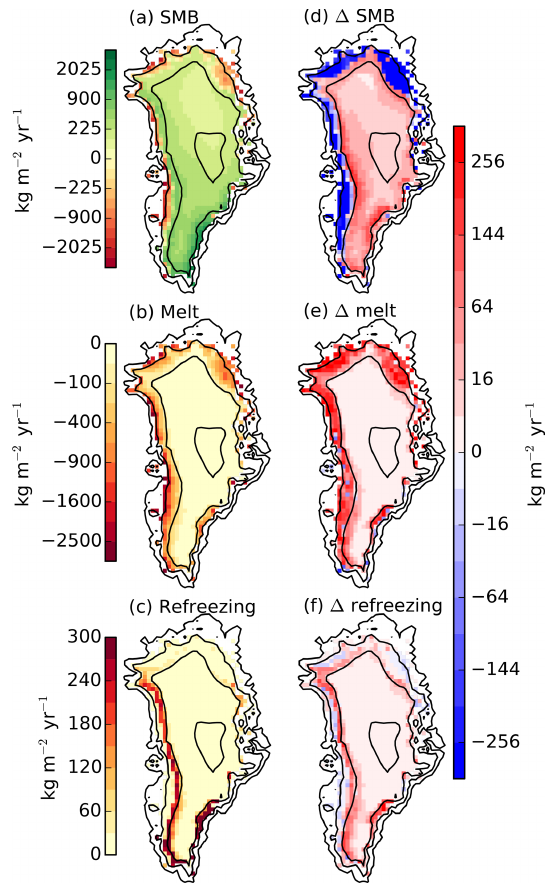
Figure 12. Surface mass balance as simulated by BEST m . Pan- els (a) , (b) , and (c) show the 1979–1990 average, panels (d) , (e) , (f) the difference 1991–2016 minus 1979–1990. Note the non-linear colour scales.